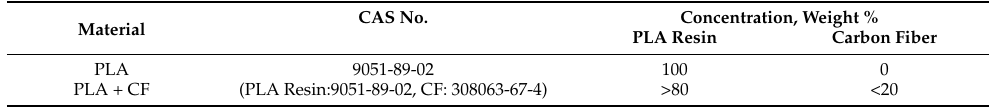
Table 1. Material compositions [31,32].